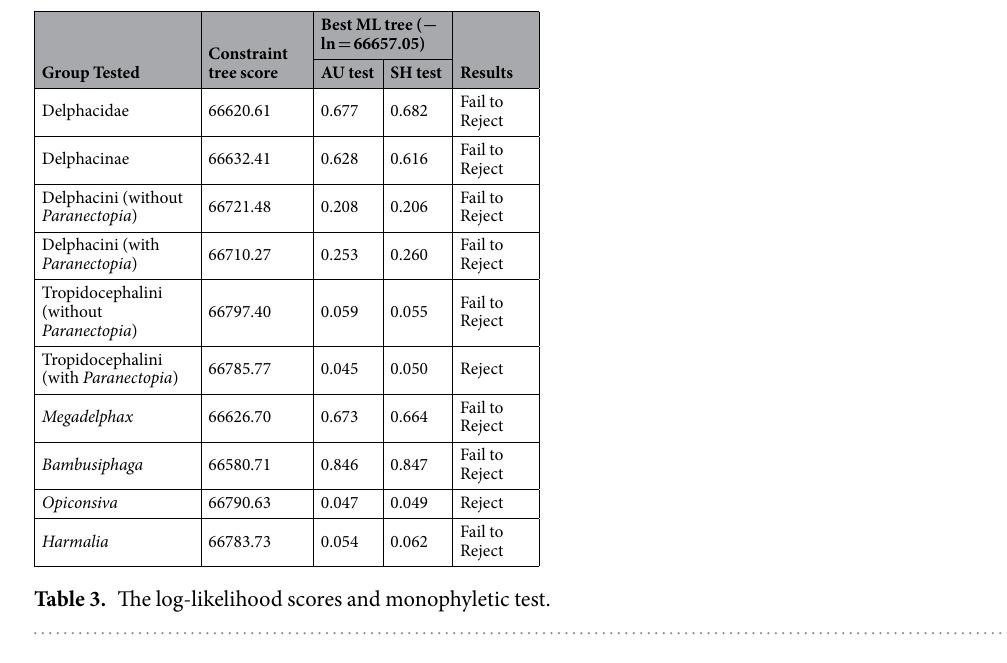
Phylogenetic analyses.